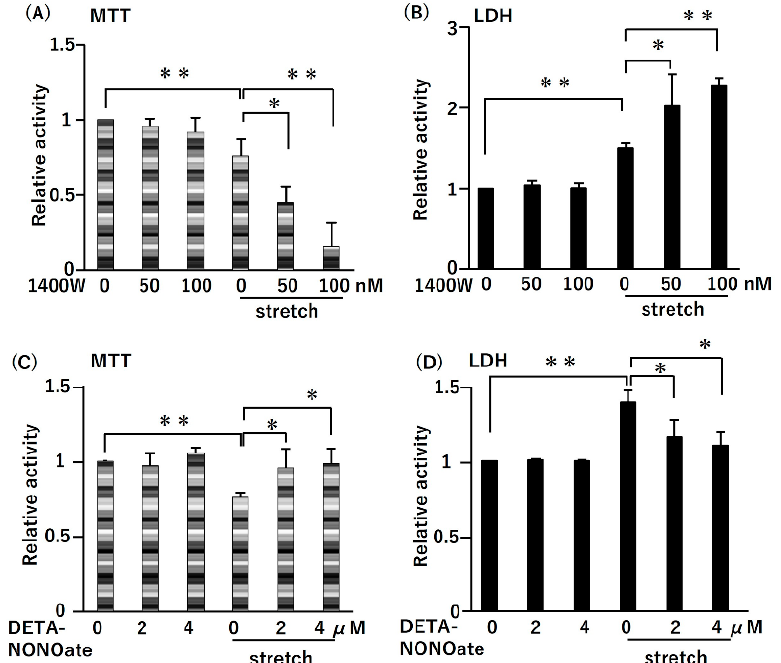
Figure 4. Effects of iNOS inhibitor and NO donor on CMS-induced cell death in RASMCs. The RASMCs were pretreated with iNOS inhibitor (1400 W, 1 h) or NO donor (DETA-NONOate, 20 min) at the indicated concentrations and then incubated under normal conditions or subjected to CMS for 4 h. After CMS, the cells were incubated for 24 h, and then cell viability and death were evaluated by the MTT ( A , C ) and LDH ( B , D ) assays, respectively. Colorimetric analysis of each value was normalized by arbitrarily setting the absorbance value of the control to 1. Data are presented as the mean ± SD ( n = 9); * p < 0.05 and ** p < 0.01 versus the CMS control.